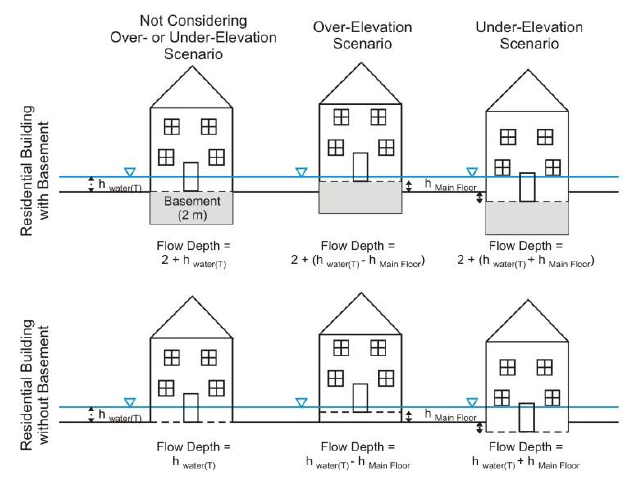
Figure 3. Flow depth estimation in the houses considering topographic over– or under–elevation with respect to the surrounding land, in the case of residential buildings both with and without a basement.